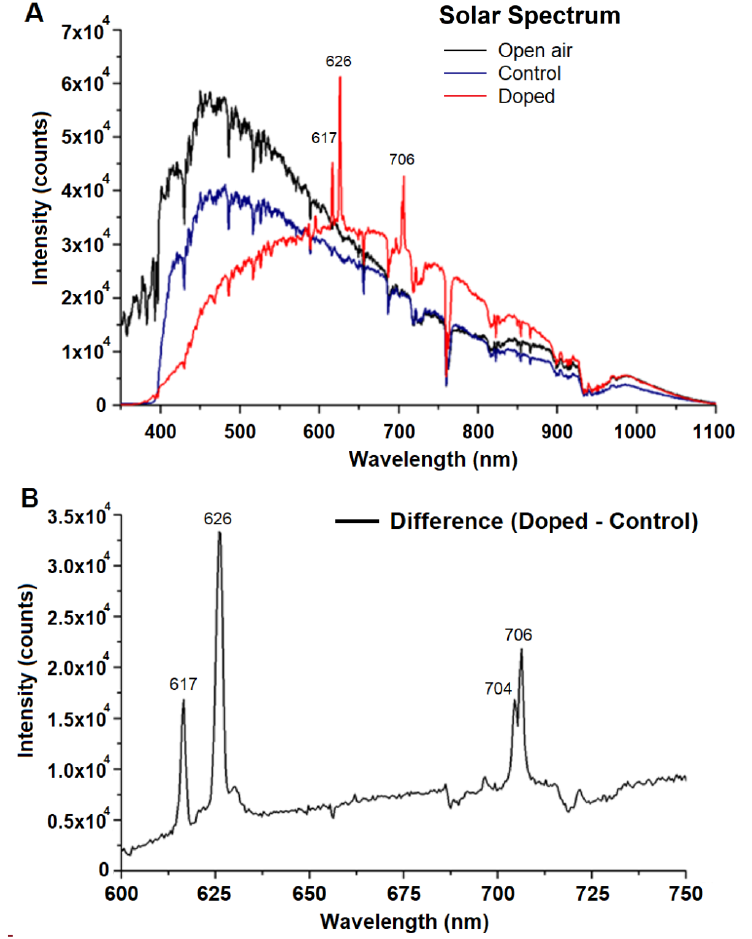
Figure 2. Analysis of the light spectra. ( A ) Spectra of transmitted light inside doped and control greenhouses and in open air. ( B ) Differential spectrum between doped and control greenhouses. The PPFD in the PAR region (total photosynthetically active radiation between 400 and 700 nm) measured at different times during the day (on 4 June 2021) highlighted a shading effect of the doped PMMA panels compared with undoped panels (Figure 3). At h 14, PAR intensity in the doped greenhouse was 529 µmol m −2 s −1 , about 36.3% lower than inside the Control greenhouse (1459 µmol m −2 s −1 ); at the same time, PAR intensity was 2042 µmol m −2 s −1 under direct sunlight. PAR measurements were taken concomitantly with the Chl a fluorescence measurements.